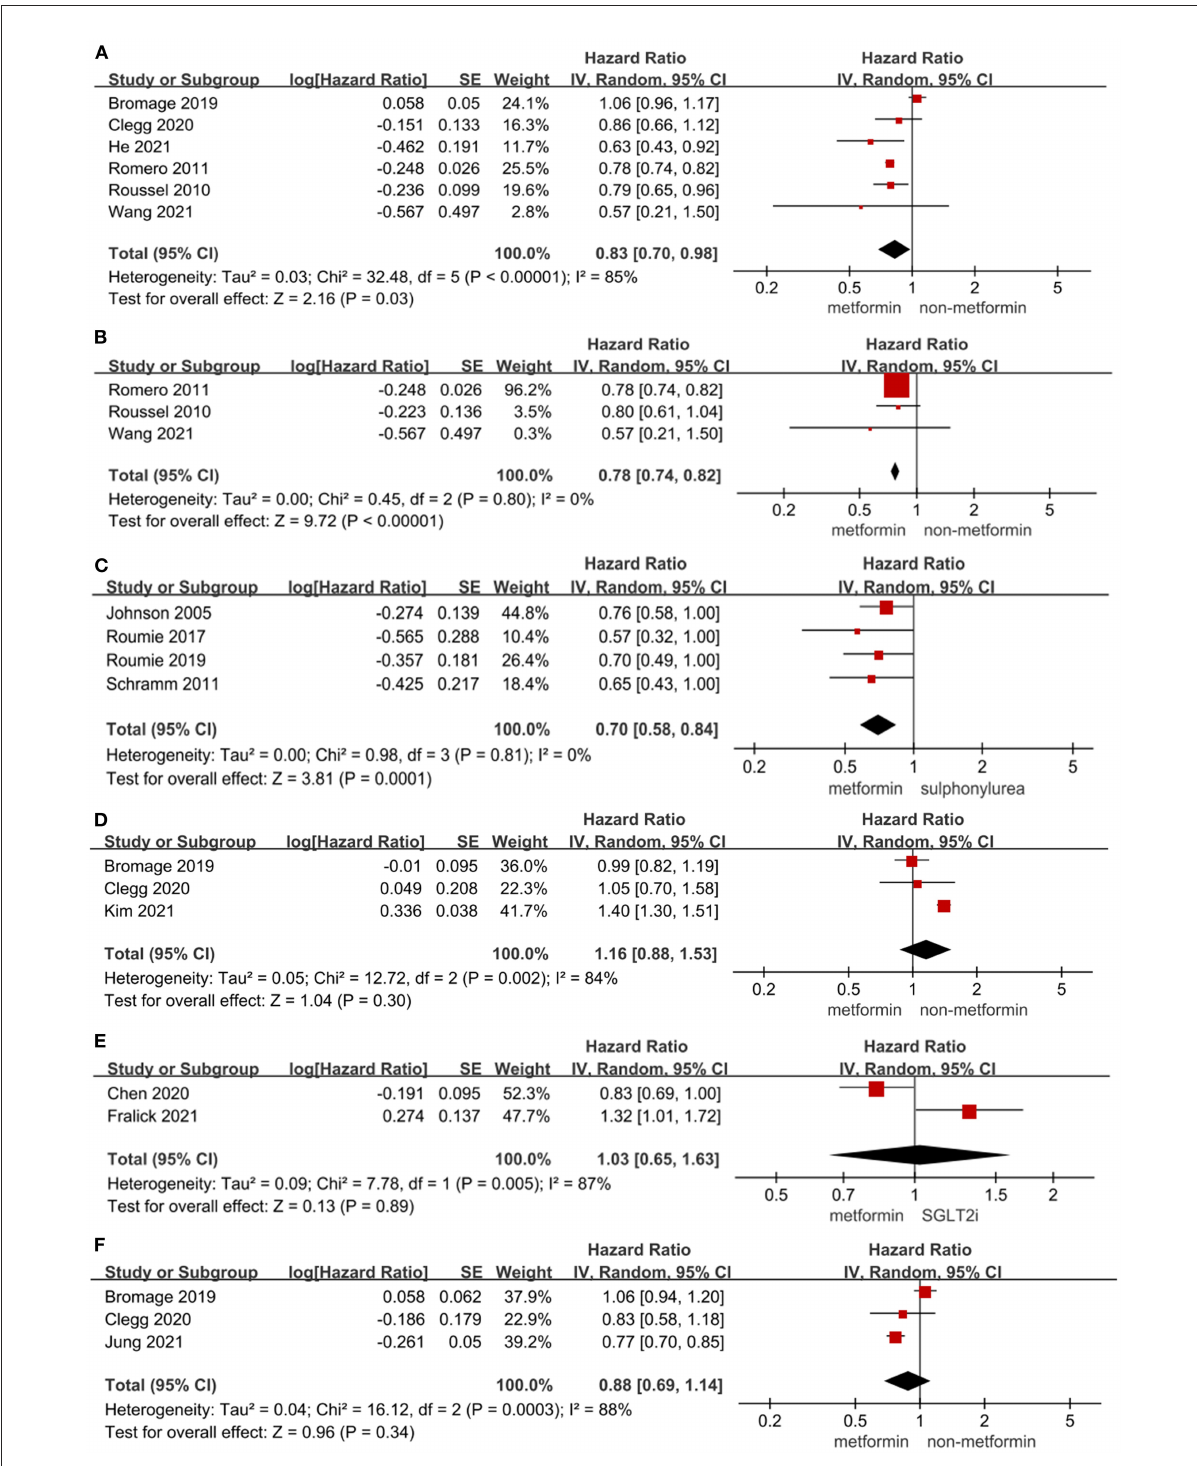
FIGURE4 (A) Forest plot of hazard ratio of cardiovascular mortality among patients with metformin therapy vs non-metformin therapy. (B) Forest plot of hazard ratio of cardiovascular mortality among heart failure patients with metformin therapy vs. non-metformin therapy. (C) Forest plot of hazard ratio of cardiovascular mortality among patients with metformin therapy vs. sulphonylurea. (D) Forest plot of hazard ratio of stroke among patients with metformin therapy vs. non-metformin therapy. (E) Forest plot of hazard ratio of stroke among patients with metformin therapy vs. SGLT2i. (F) Forest plot of hazard ratio of AMI among patients with metformin therapy vs. non-metformin therapy. CI, confidence interval; SE, standard error; IV, inverse of the